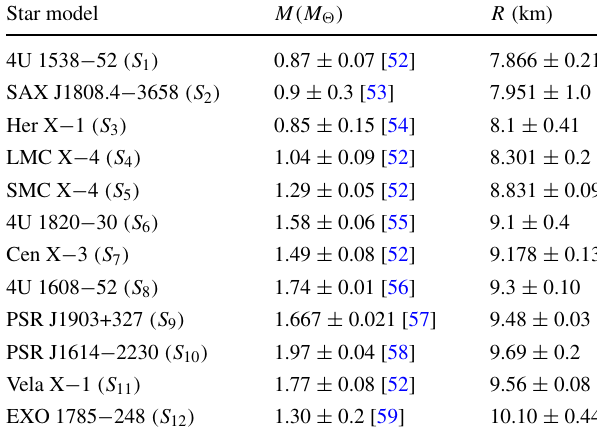
Table 1 Approximated values of input parameters Star